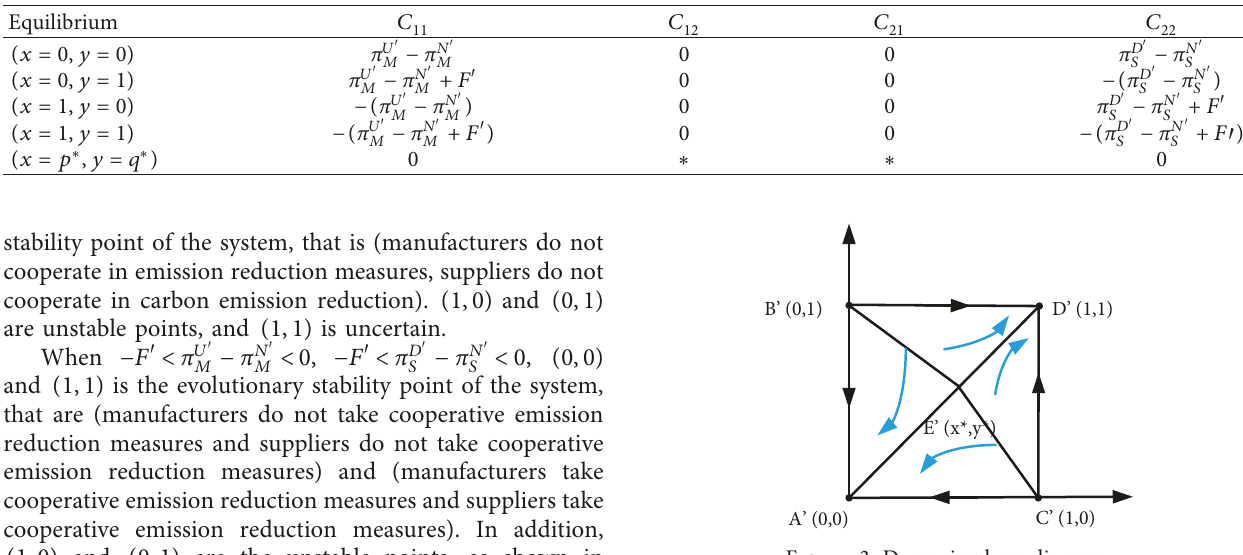
Table 4: The value at the C 11 C 12 C 21 C 22 local equilibrium.